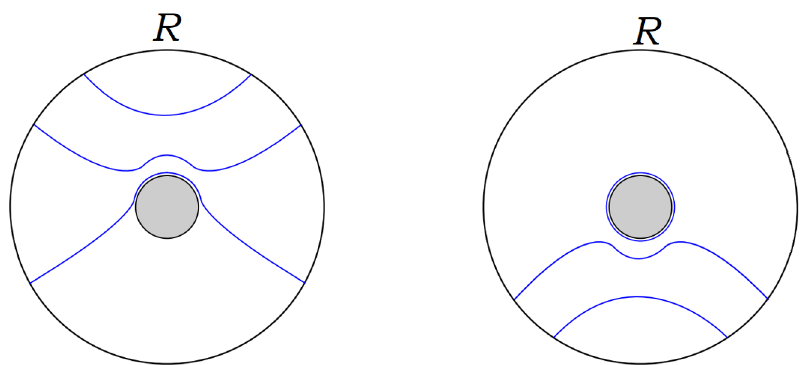
Figure 16 . We consider the minimal surface for a region R on one side of the thermofield double in AdS 3 . There is a transition from the left diagram to the right, where the minimal surface becomes disconnected and has a component which coincides with the event horizon of the black hole. This happens at an O (1) fraction of the boundary system